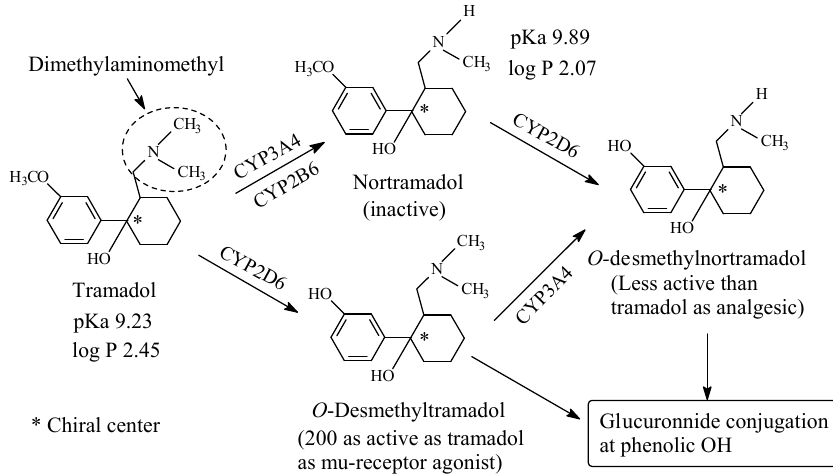
Figure 26. Metabolic pathways of tramadol.